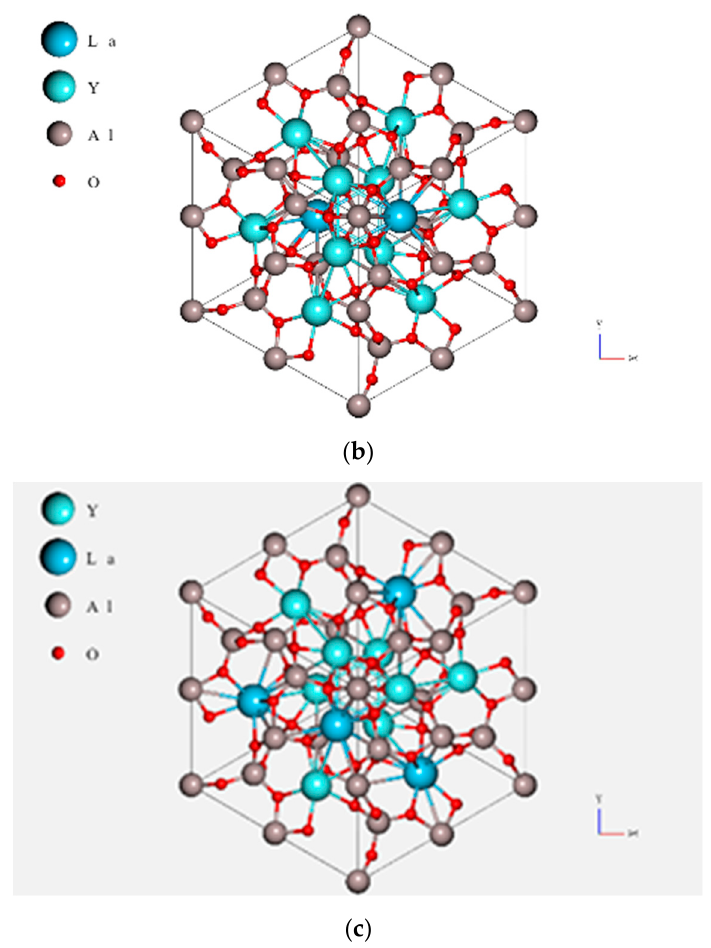
Figure 1. Elementary lattices of Y 3 Al 5 O 12 : ( a ) Y 3 Al 5 O 12 ; ( b ) Y 3 Al 5 O 12 :La (2 ions); ( c ) Y 3 Al 5 O 12 :La (4 ions).